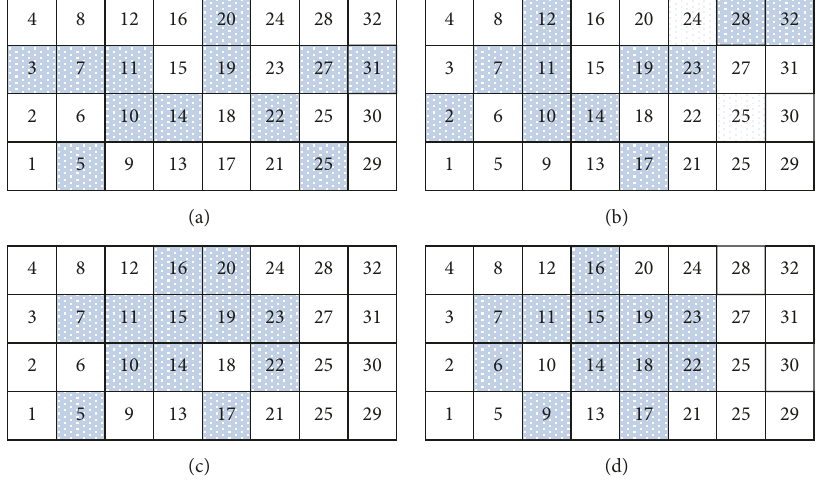
Figure 13: Configuration diagrams of piezoelectric actuators at different evolution periods: (a) 20 generations; (b) 130 generations; (c) 320 generations; (d) 2000